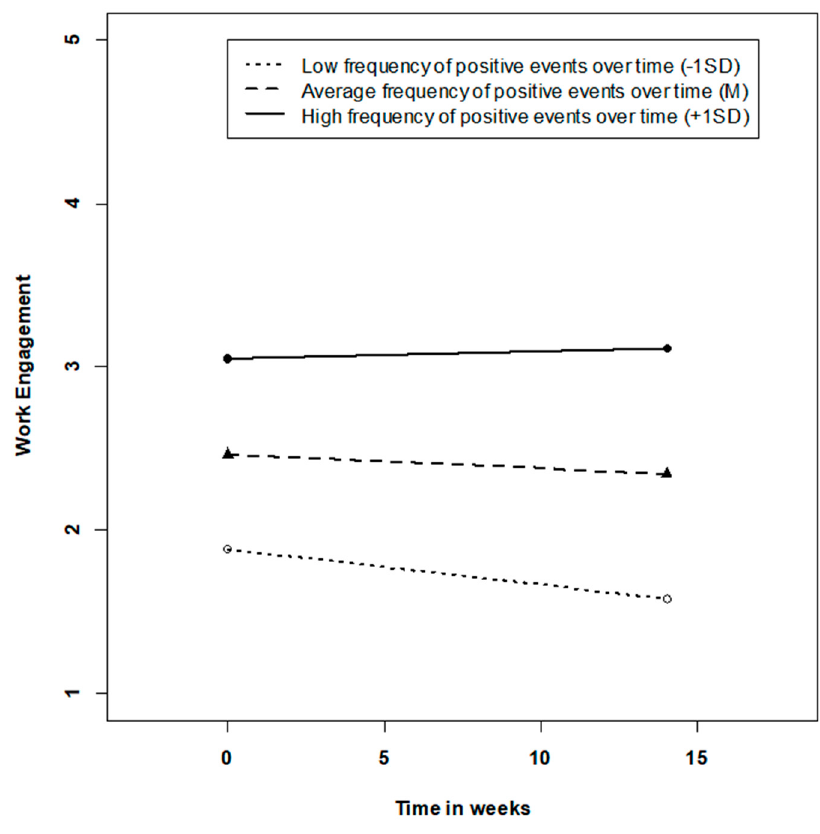
Figure 3. Trajectories of work engagement over 15 weeks dependent upon the accumulation of positive events over time.